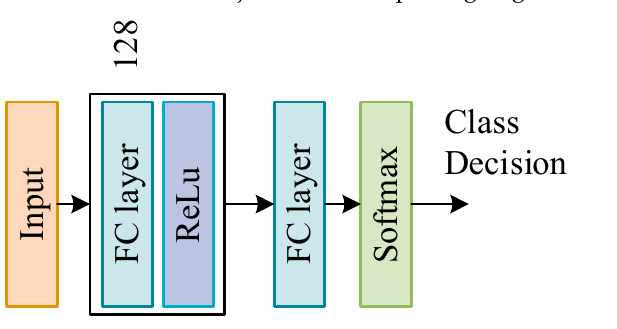
Figure 6. The composition of the new training set and test set.